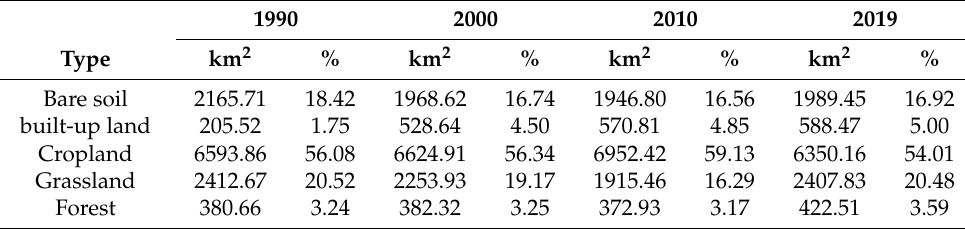
Figure 8. Land use change maps from 1990 to 2019. CL: cropland; GL: grassland; FR: forest; BS: bare soil. ( a ) land use maps for 1990, 2000, 2010 and 2019; ( b ) changes between different periods. Table 4. Areas and percentages of different land use types from 1990 to 2019 in the